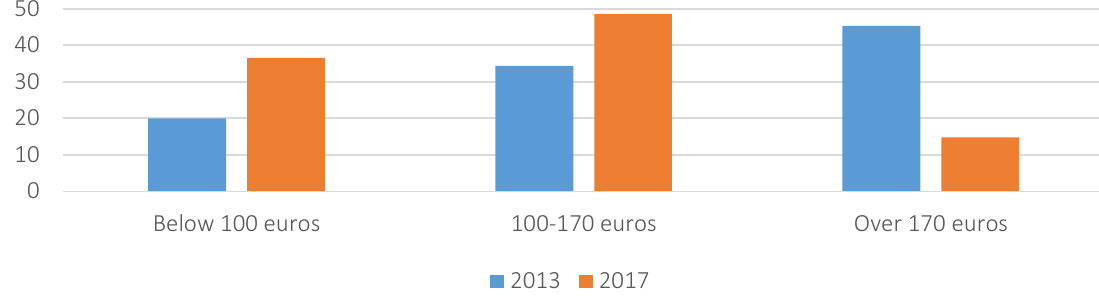
Figure 3. Distribution of Ukrainian people by monthly income per capita in 2013 and 2017,